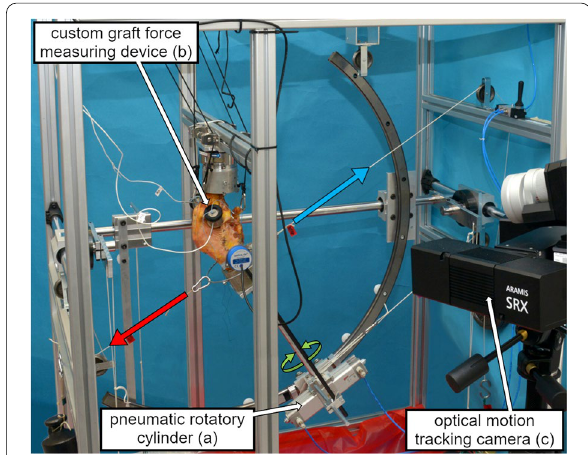
Fig. 2 The biomechanical knee joint test bench [17] with a knee specimen fixed at 30° of flexion. Anterior tibial translation force (red arrow) is induced by a pulley-and-weight system. A pnemuatic rotatory cylinder ( a ) is used to apply internal tibial torque (green arrow). The tibial weight is compensated in relation to the flexion angle by another pulley-and-weight system (blue arrow). Graft forces and tibiofemoral joint motion are measured by custom graft force measuring devices (incorparating a load cell) ( b ) and an optical 3D camera system ( c )